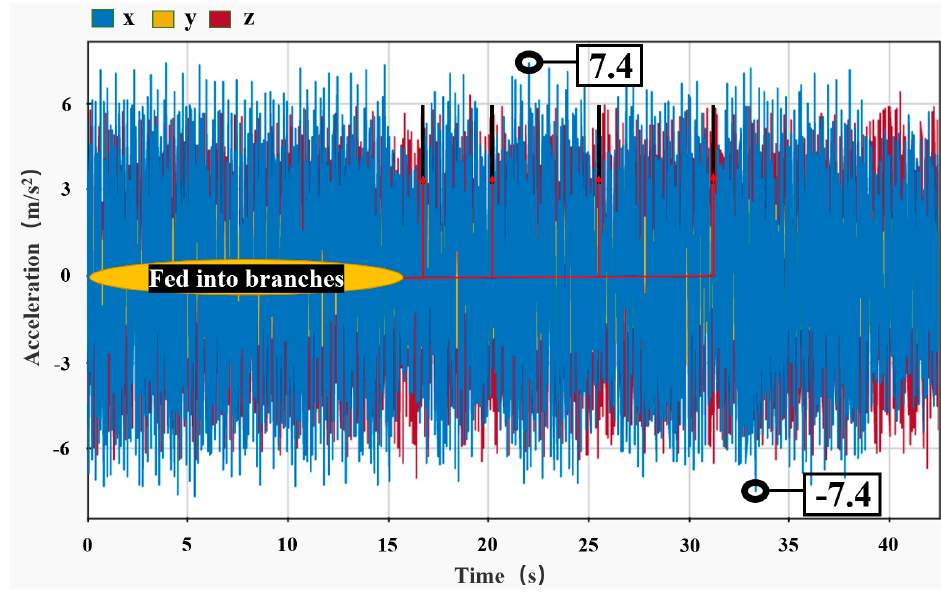
Figure 15. Static comminution test results of the carrier platform of the chipper.